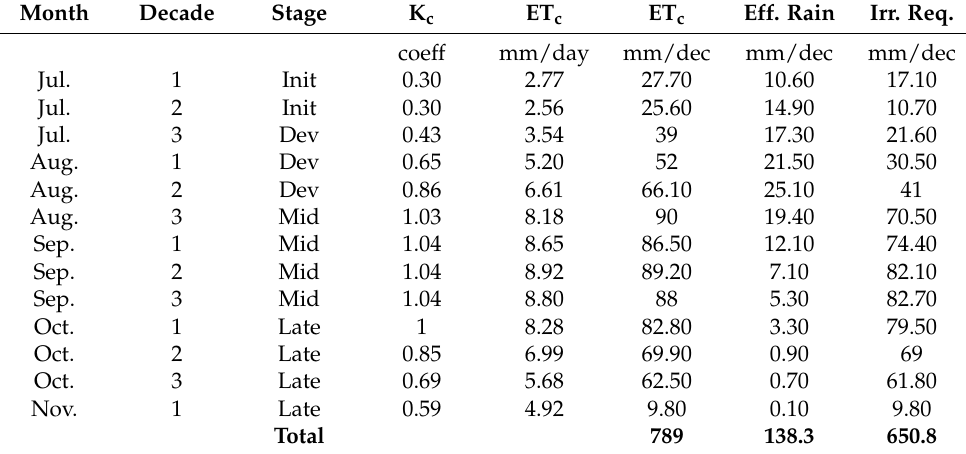
Table 6. Crop water requirements for